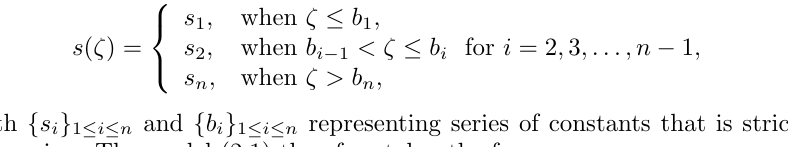
The modification of the above function s ( ζ )